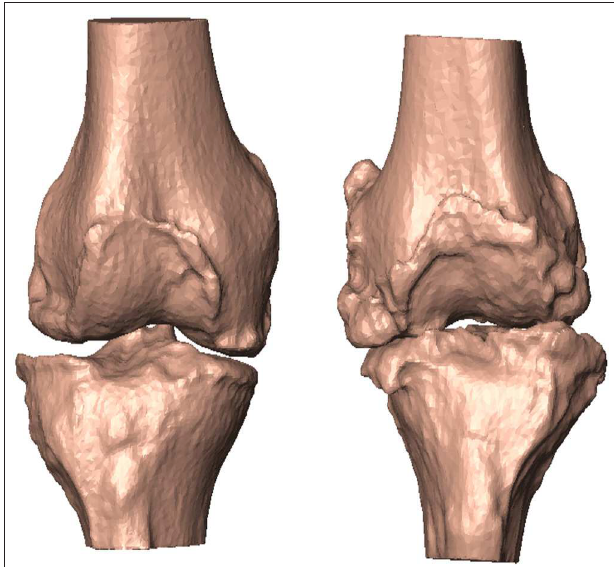
FIGURE 2 | According to the five angular quantities, patient # 20 featured no alignment deformation (left) . Patient # 29, in contrast, featured mechanical instability in all but one (IER) angular quantities (right) .